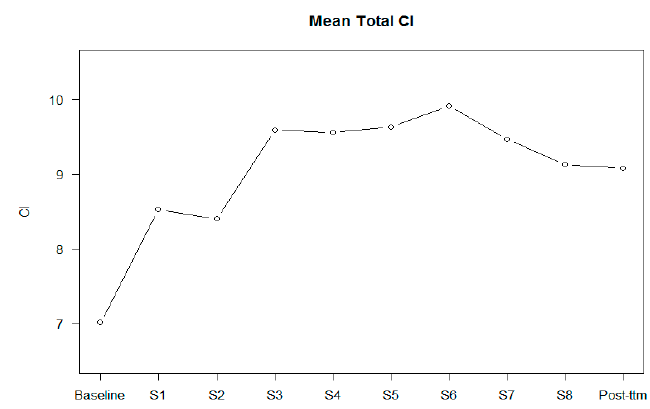
Figure 4. Mean of the Composite Index (CI) in each session and in the post-treatment.